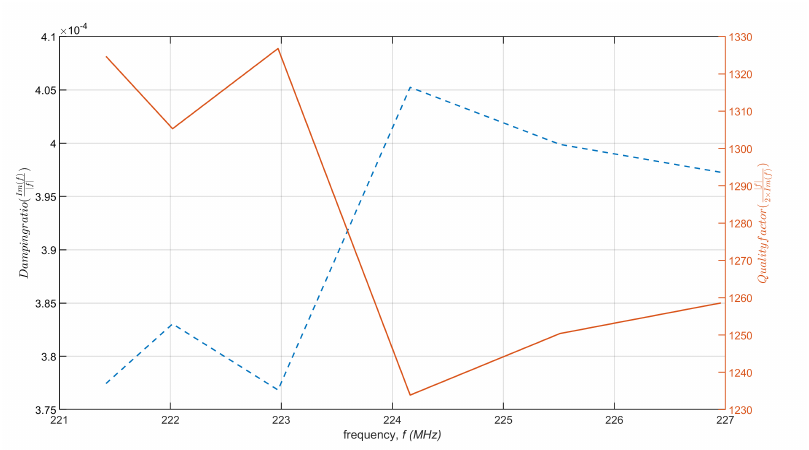
Figure 16. Damping ratio (blue dashed-line) and quality factor (red line) as a function of frequency.